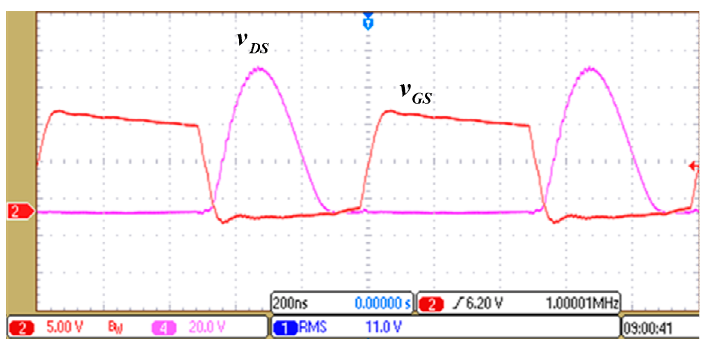
Figure 21. Waveforms of v GS and v DS , when iron plate at line l 2 and d 2 = 10 cm, after changing the compensation capacitance C 1 .